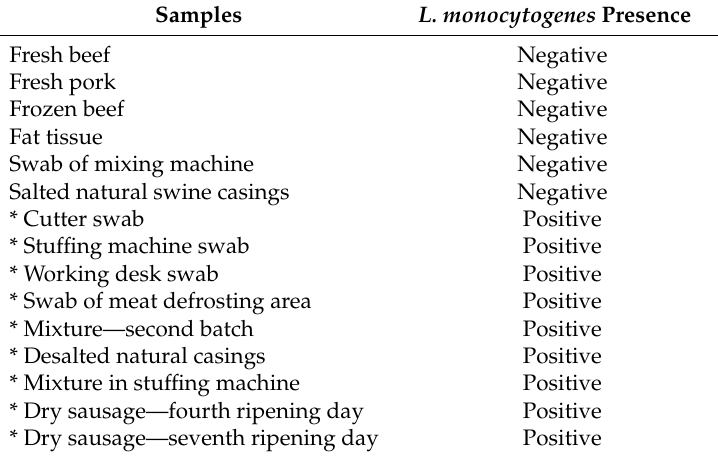
Table 1. Results of Listeria monocytogenes testing of raw materials, swabs, and sausage mixtures.